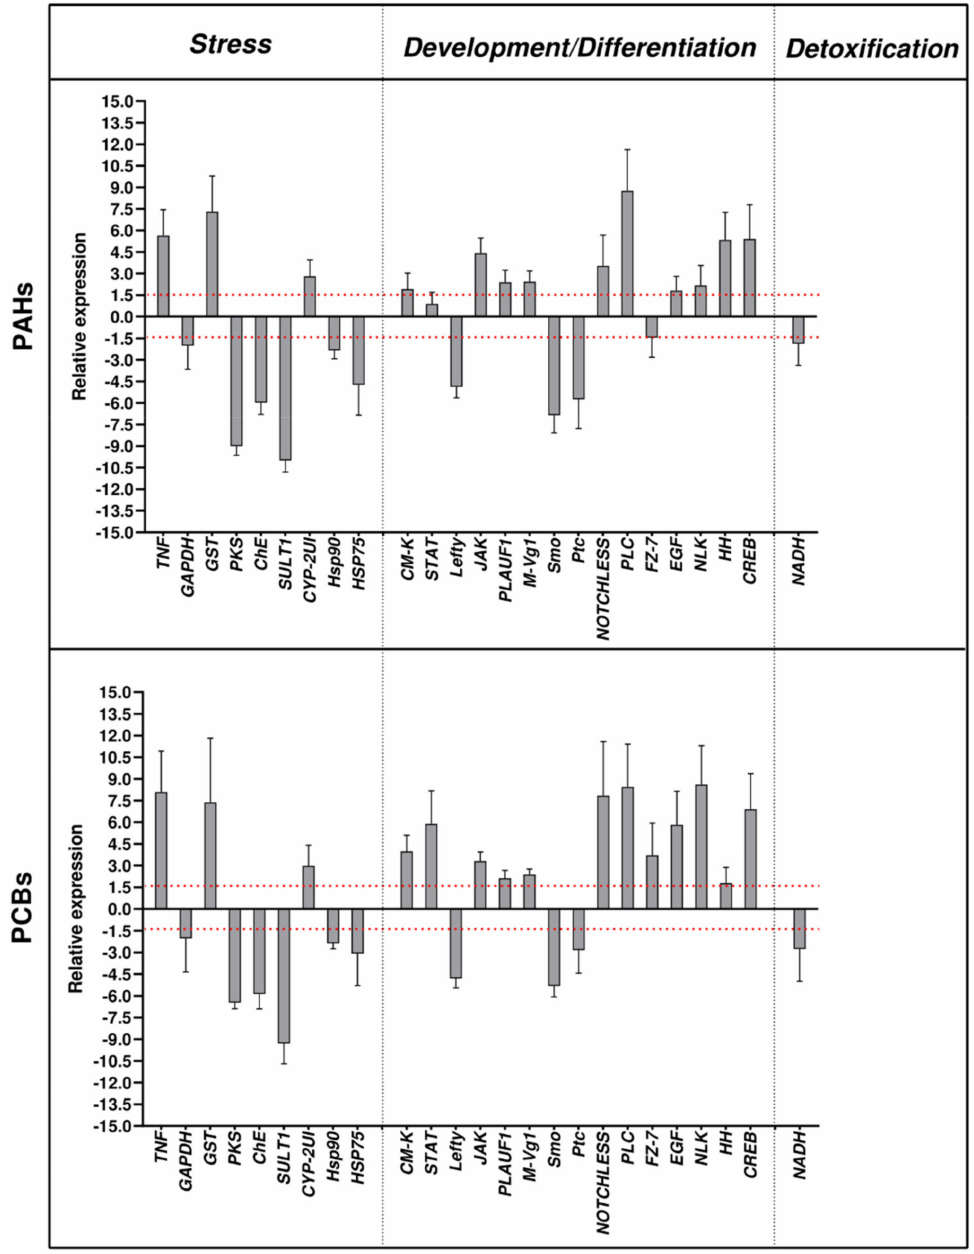
Figure 1. Real-time qPCR at the pluteus (48 hpf) stages of the sea urchin P. lividus embryos, deriving from adults exposed for 2 months to sediments contaminated with PAHs and PCBs. Data are reported as a fold difference compared with control embryos, deriving from adults reared in tanks with non- contaminated sediments (mean ± SD). Histograms show the fold-changes of 25 genes involved in three functional processes: stress response, development/differentiation and detoxification. Fold differences greater than ± 1.5 (see red dotted horizontal guidelines at values of +1.5 and − 1.5) were considered significant. Real-time qPCR reactions were carried out in triplicate. Statistical differences were evaluated by nonparametric Mann–Whitney test. p -values < 0.05 were considered